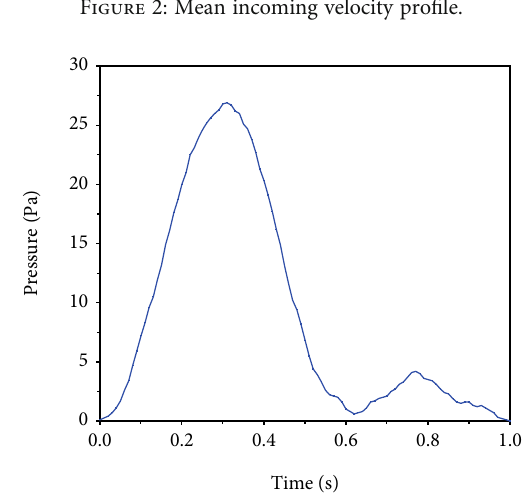
Figure 3: Pressure pulse applied at outlet boundary